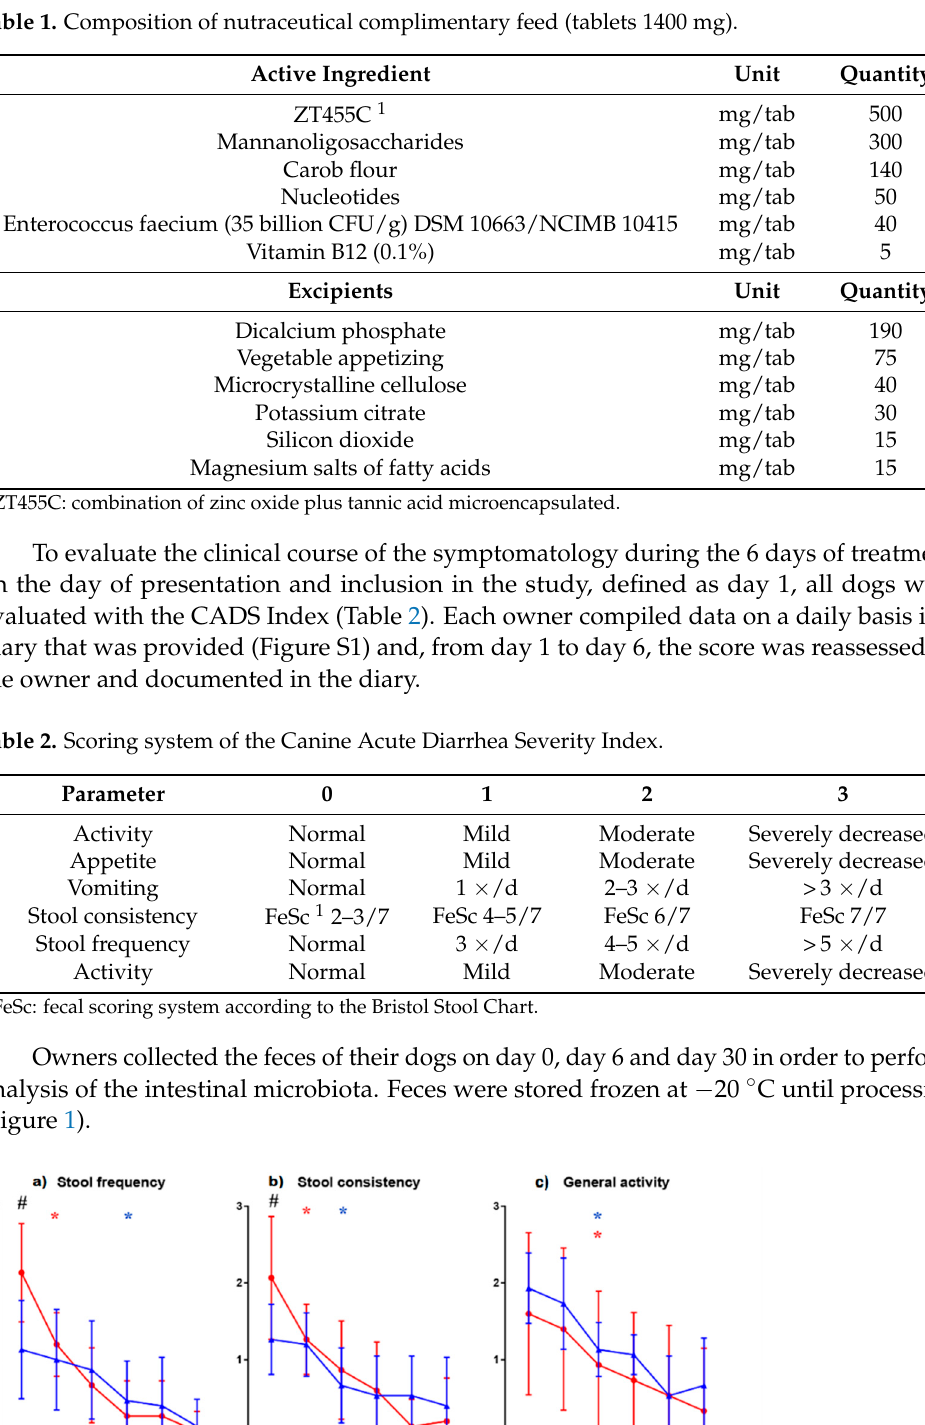
Figure 1. Mean values (y axes) for the parameters ( a ) stool frequency, ( b ) stool consistency, ( c ) general activity, ( d ) appetite, ( e ) vomiting and ( f ) CADS in the groups of dogs treated with com- plementary feed (group A; red) and antimicrobials (group B; blue). * Day on which the mean sig- nificantly decreased compared to day one for each group; color indicates group ( p < 0.05). # Differ- ence between treatments at any point in time ( p < 0.05). 2.3. Clinical Procedures The veterinarian collected the dogs’ history and performed the physical examination on day 0 and day 6, reporting the data in the patient medical record. Complete blood count, biochemical examination and fecal examination (flotation test, Giardia antigen with IDEXX SNAP Giardia Test (DEXX SNAP ® Giardia, IDEXX La- boratories Inc., Westbrook, ME, USA) in order to detect possible parasitic infestation were performed on all dogs prior to the enrollment in the study. 2.4. Microbiome Analysis DNA was extracted from each fecal sample (100 mg) using the MoBio Power soil DNA isolation kit (MoBio Laboratories, Carlsbad, CA, USA) according to the manufac- turer’s instructions. Quantitative PCR assays (qPCR—BioRad Laboratories, CA, USA) were performed for key bacterial taxa included in the final canine qPCR-based DI which have all been shown to be altered in previous sequencing and qPCR-based studies be- tween healthy dogs and dogs with intestinal inflammation (i.e., total bacteria, Faecalibac- terium , Turicibacter , Escherichia coli , Streptococcus , Blautia , Fusobacterium and Clostridium hiranonis ) as previously described [25–27]. While all of the bacterial taxa analyzed were significantly different between healthy dogs and dogs with CE, the combined results ex- pressed as DI had the highest discriminatory power. This is explainable due to the known individuality in the abundances of specific bacteria taxa between dogs [28], and measure- ment of the abundance of one single taxon cannot distinguish between health and disease with high accuracy. Briefly, qPCR reactions were performed using SYBR Green-based reaction mixtures. The qPCR results were expressed as the log amount of DNA for each bacterial taxon/10 ng of isolated total DNA. The results of the qPCR assays were also combined to calculate the Dysbiosis Index, which expresses the degree of dysbiosis as a single numeric value. A negative DI indicates eubiosis, whereas a positive DI indicates dysbiosis [25–27].